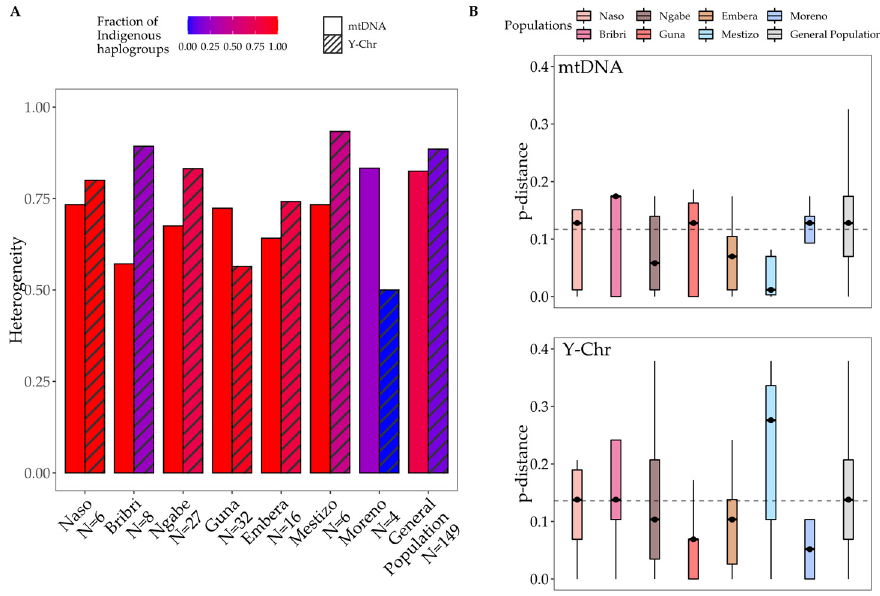
Figure 4. Heterogeneity based on haplogroup frequencies ( A ) and intra-population uniparental genetic pairwise distances ( B ) of different Panamanian groups computed for mtDNA and the Y-chromosome. In panel A, heterogeneity bars are shaded (from blue to red) according to the proportion of Indigenous lineages in each population. In panel B, dashed lines represent the mean value of all distances for mtDNA (above, mean = 0.12) and for the Y-chromosome (below, mean = 0.14).